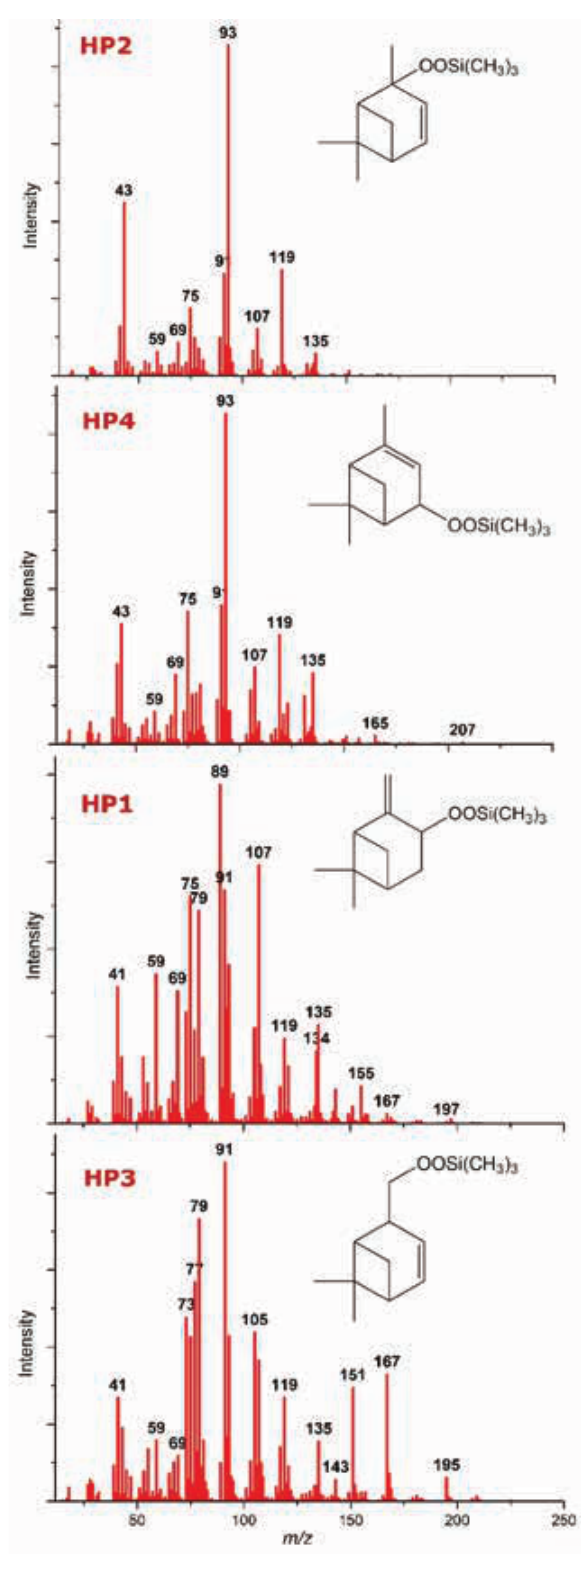
Figure 5. Mass spectra of the TMS derivatives of α-pinene HPs: 4-Hydroperoxy-4,6,6-trimethylbicyclo[3.1.1]hept-2-ene (HP2), verbenyl-hydroperoxide (HP4), pinocarvyl-hydroperoxide (HP1) and myrtenyl-hydroperoxide